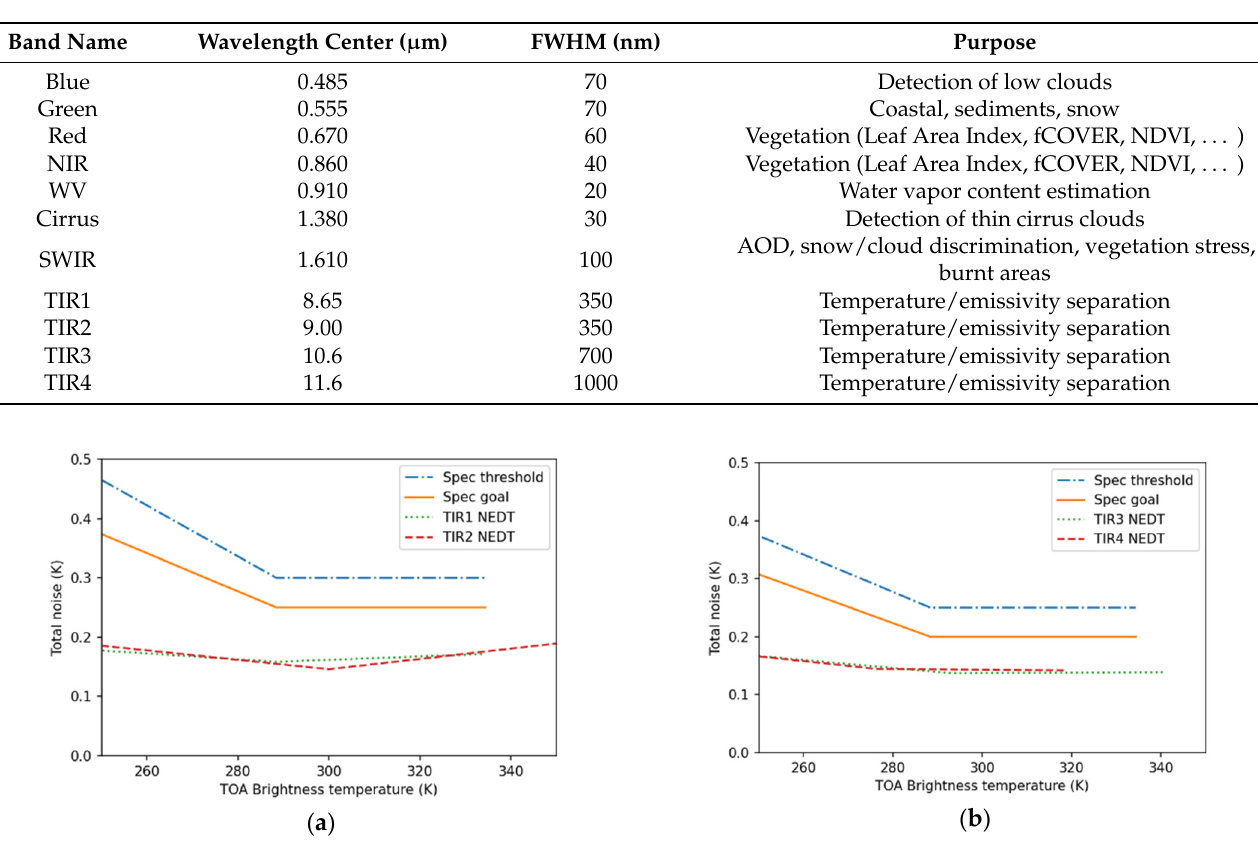
Figure 1. Total noise equivalent differential temperature (NEDT) for TIR1&2 ( a ) and TIR3&4 ( b ) and comparison with the specifications, as a function of TOA brightness temperature.